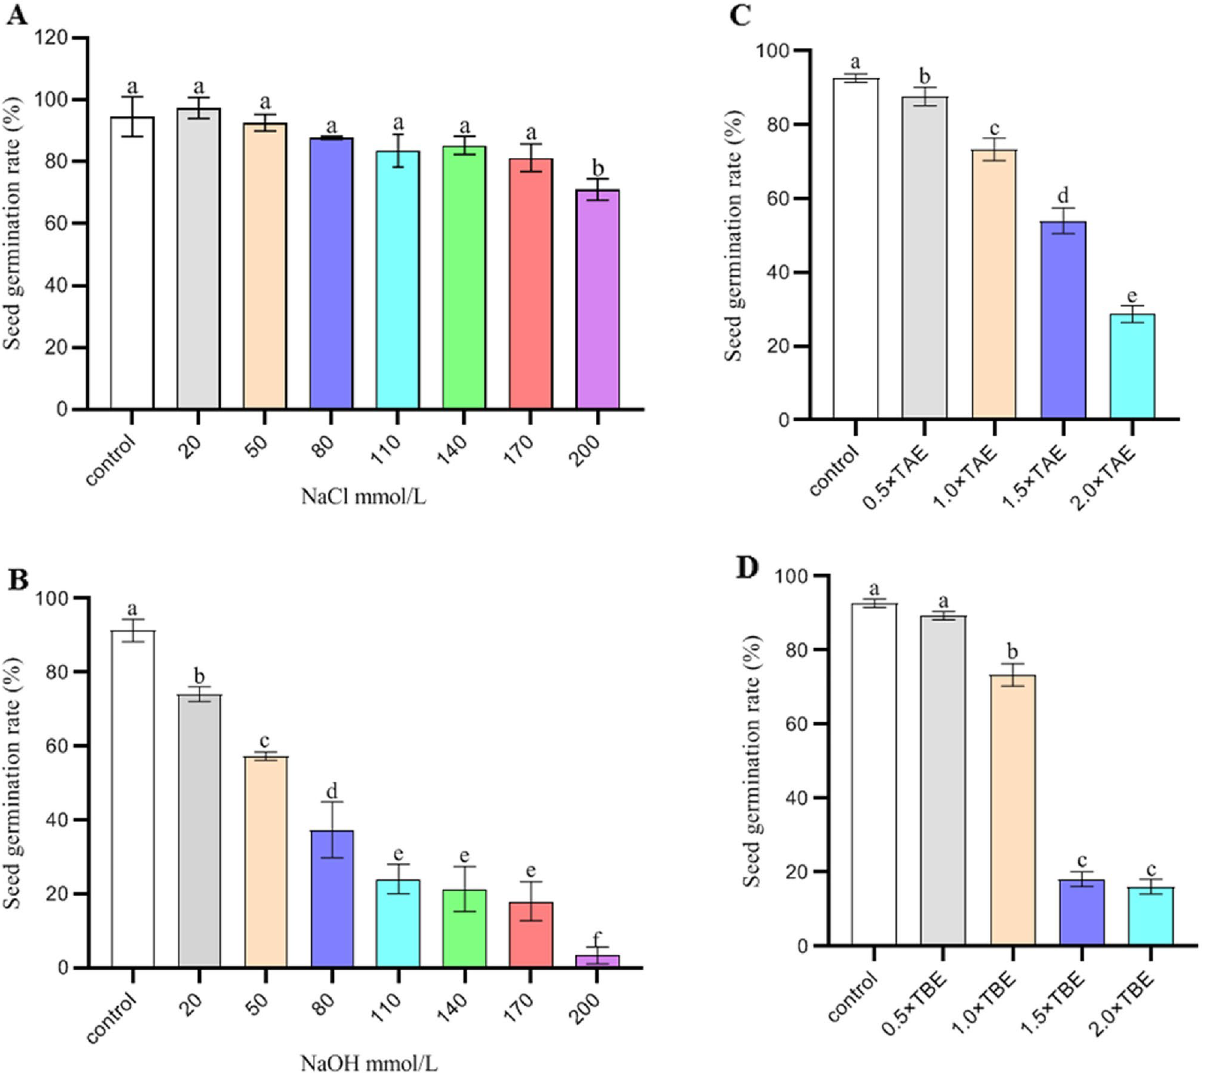
Figure 1. Germination rate of rice seeds at different solution concentrations. ( A ) NaCl solution; ( B ) NaOH solution; ( C ) TAE buffer; and ( D ) TBE buffer. The error bars stand for standard deviations. Control: sterile water, different letters in each column indicate significant differences between different treatments ( p < 0.05; Duncan’s